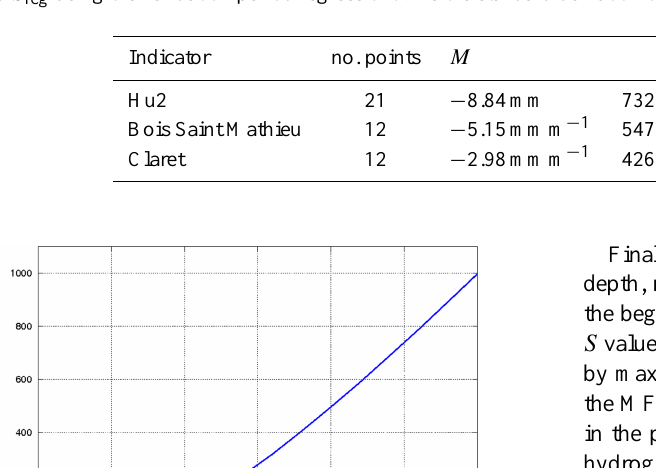
Table 2. The S – catchment wetness state indicator relationship. M is the slope of the linear regression between S cal and the wetness state indicator, b is the y-intercept, and R 2 is the coefficient of determination for this regression. % change refers to the average difference between S reg and S reg using the validation period regression. σ is the standard deviation of this difference.